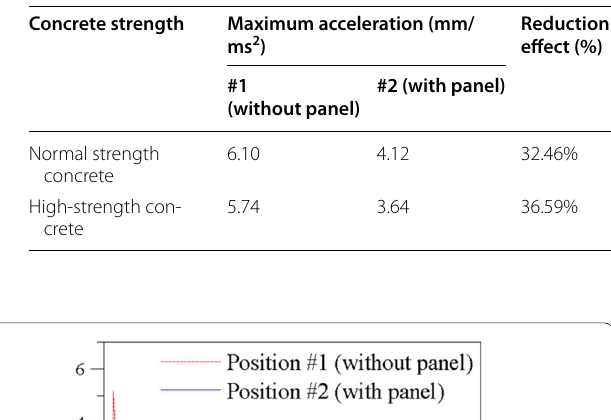
Table 4 Vibration reduction effect of blast‑proof panel